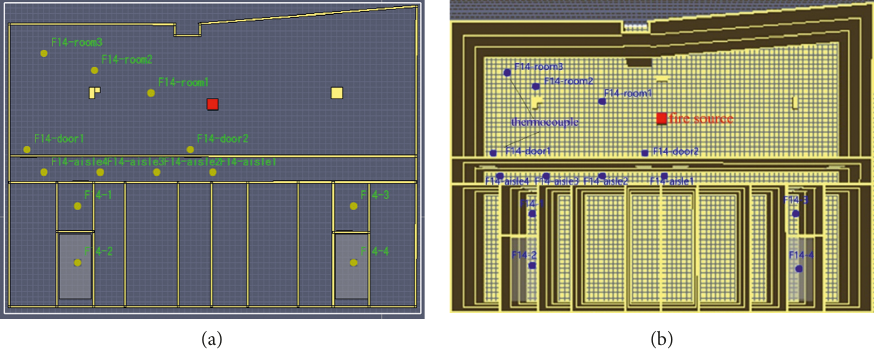
Figure 8: Thermocouple arrangements of F14. (a) 2D thermocouple arrangements; (b) 3D thermocouple arrangements.